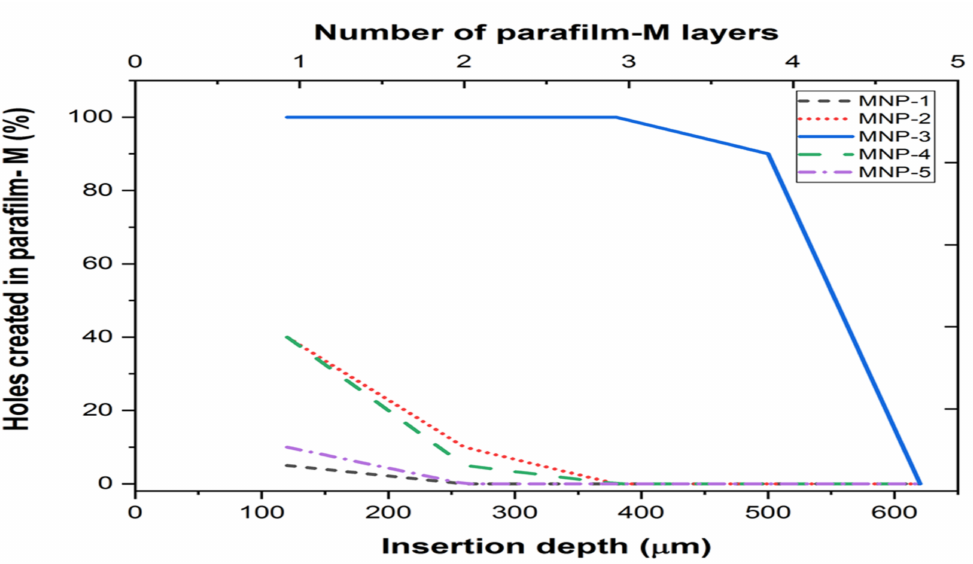
Figure 12. Measurement of the insertion depth of LS-TC-MNPs and percentage of hole formation in parafilm-M to study the penetration ability of microneedle patches.